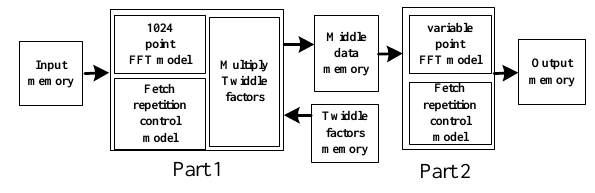
Fig.1 Large points and reconfigured FFT system The two parts’ main function modules are both FFT arithmetic. In each part, except FFT module, there are fetch data module, repetition control model. The FFT module completes the column transformation and the row transformation’s butterfly operation. The fetch data module and the repetition control module